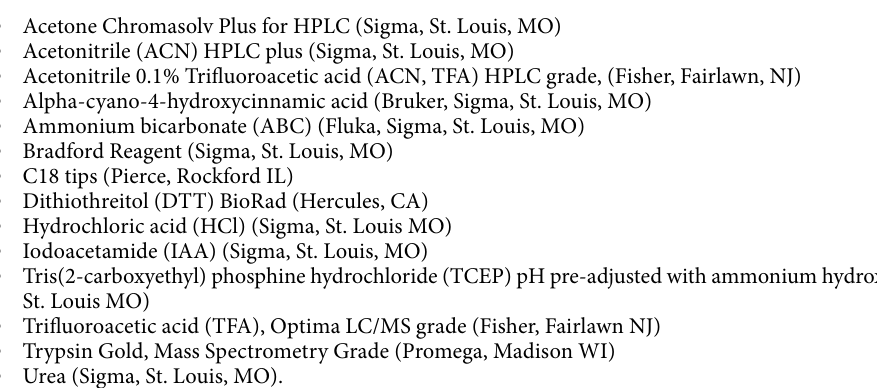
Figure 2. Relative ranking of species and order by peptides identified in five WWII disks. ( A ) ranks the disks by orders. The percent of spectra below the dotted lines represent peptides shared between all orders in a given disk. ( B )–( F ) X-axes identify all peptides found in a particular disk as well as the number of times that peptide was independently detected. (Sequences for ( F ) may be found in Supplementary Table 3) Y-axes indicates possible species assignments using different combinations of the identified peptides. Percentages reflect the number of peptides used for a species assignment as a total of all peptides identified (only species that explained > 50% of the data are shown). Only in the North Carolina disk ( B ) is human the most likely species interpretation (65% of peptide, tied with polar bear*). The only other disk with human specific peptides is Yad Vashem disk 5910 where human represents the third largest number of peptides (60%, again tied with polar bear), while sheep/goat (93%) and cow/deer (87%) are higher. *Identification of non-European wildlife, e.g. polar bear, Virginia white-tailed deer, alpaca, etc. are likely due to limitations of databases for the European species of these genera. For example, both polar bears ( Ursus maritimus ) and Eurasian brown bears ( Ursus arctos arctos ) are of the same